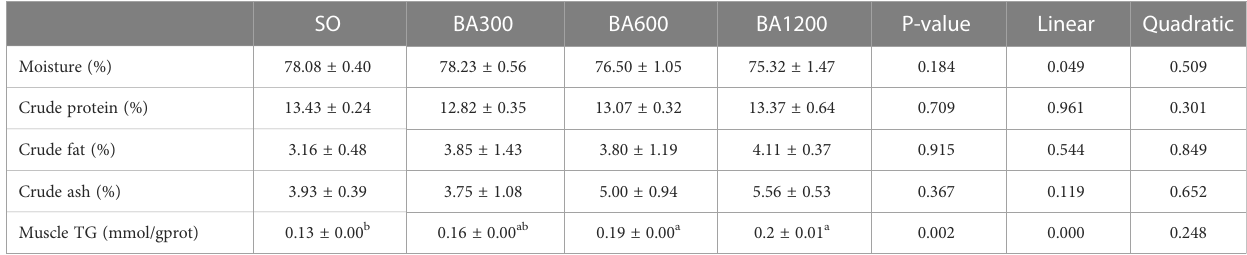
TABLE 4 Body composition of juvenile large yellow croaker in different treatments (Means ± SEM, n = 3) 1 .